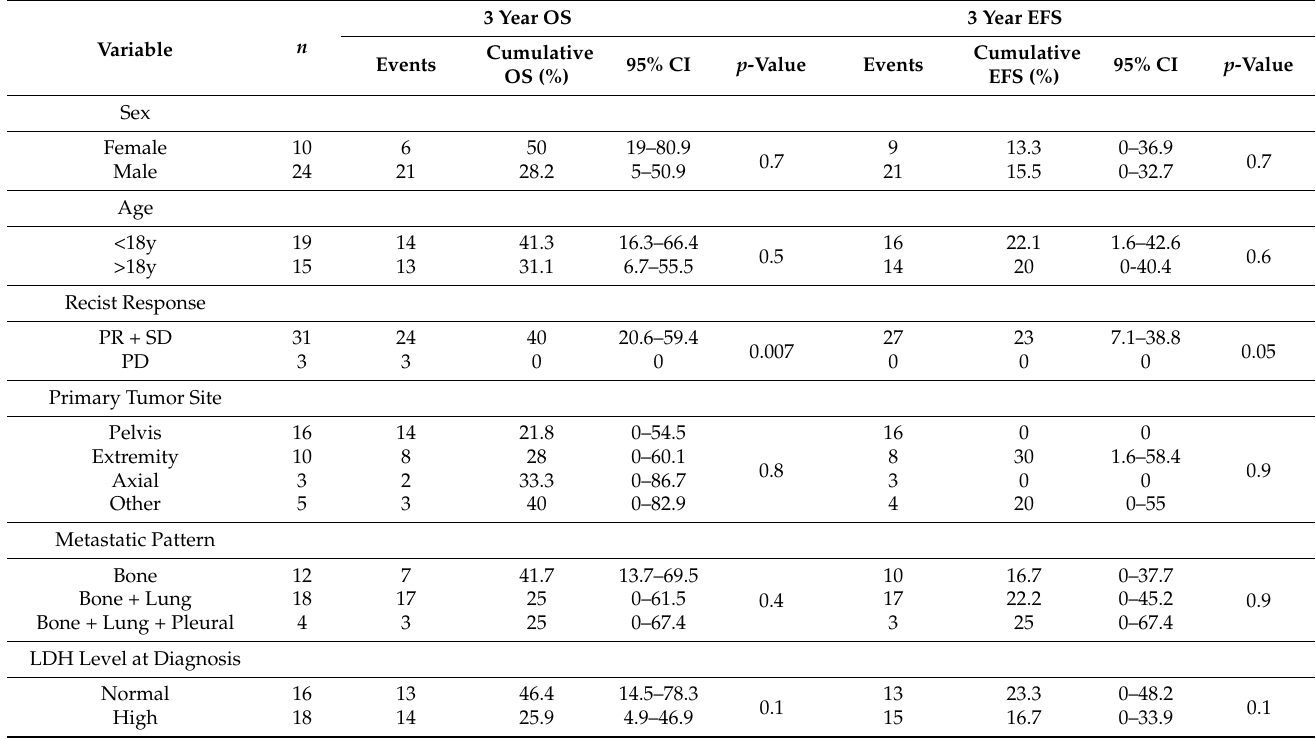
Table 4. Univariate analysis for Overall Survival (OS) and Event Free Survival